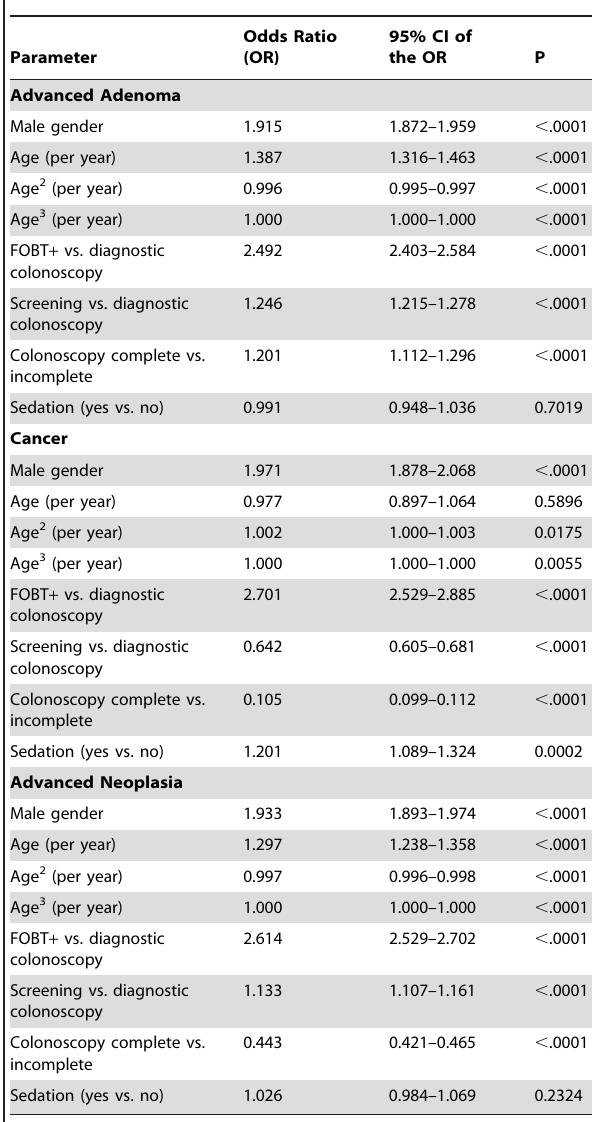
Table 3. Predictors of advanced adenoma, carcinoma, and advanced